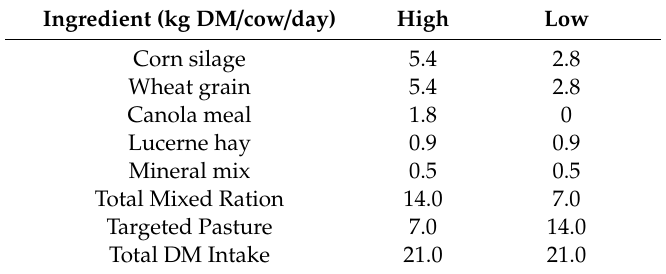
Table 2. Diet composition for high and low mixed ration levels with targeted pasture